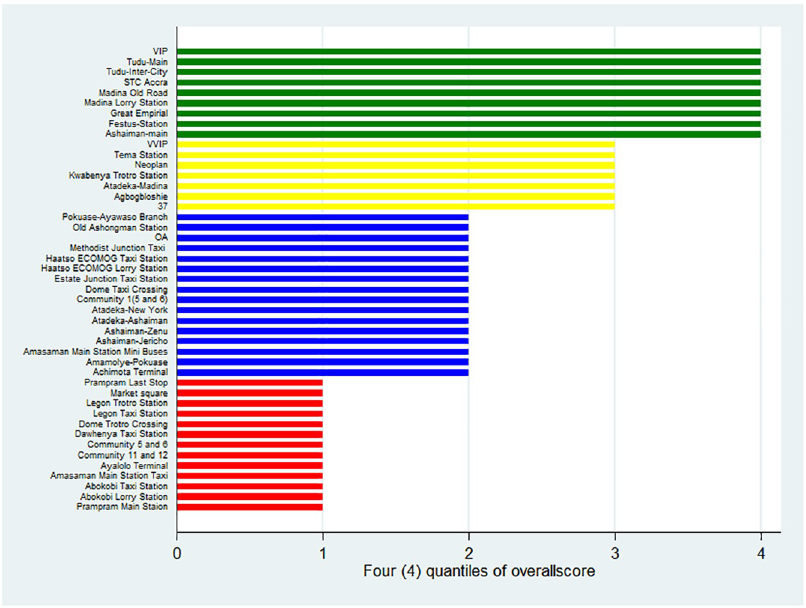
Fig 1. Compliance of transport stations distributed by quantiles (n =